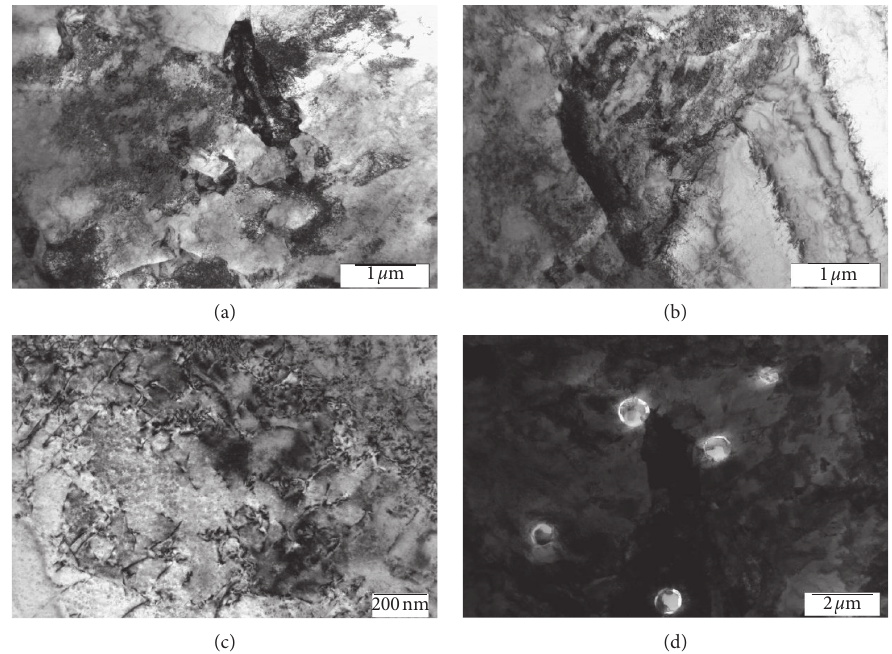
Figure 6: Microstructures of the as-cladded 2.25Cr1Mo0.25V sample made by WAAM: (a) bainite, (b) M-A constituent, (c) dislocations, and (d) inclusions.